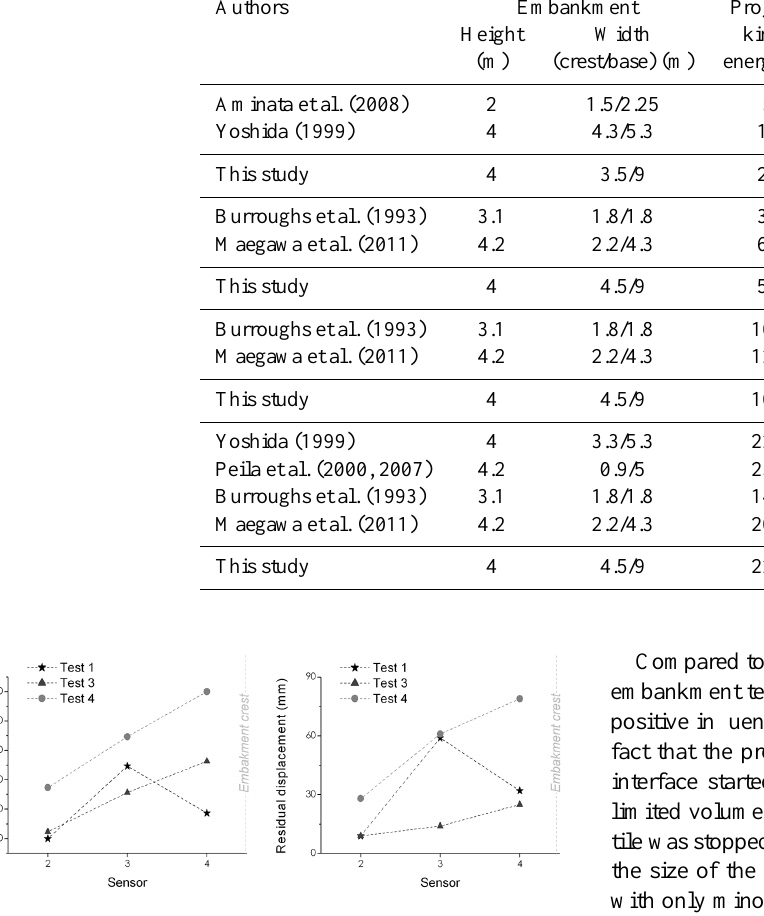
Figure 16. Maximum and residual incremental displacements at the kernel–levee interface in the impact plane after each impact (sensors A 2 , A 3 and A 4